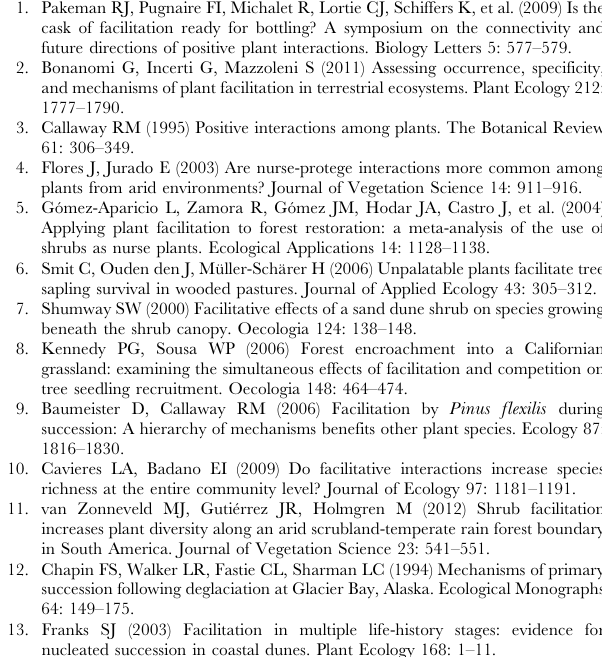
Figure S1 Monthly precipitation in the region of the study site.